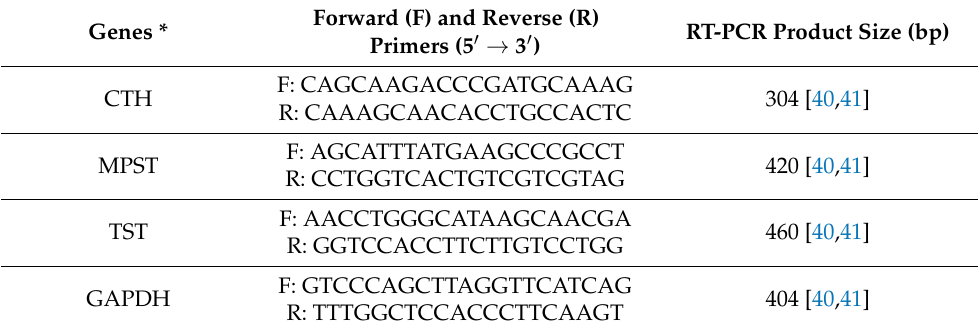
Table 1. Primer sequences used for reverse-transcription polymerase chain reaction (RT-PCR). Genes